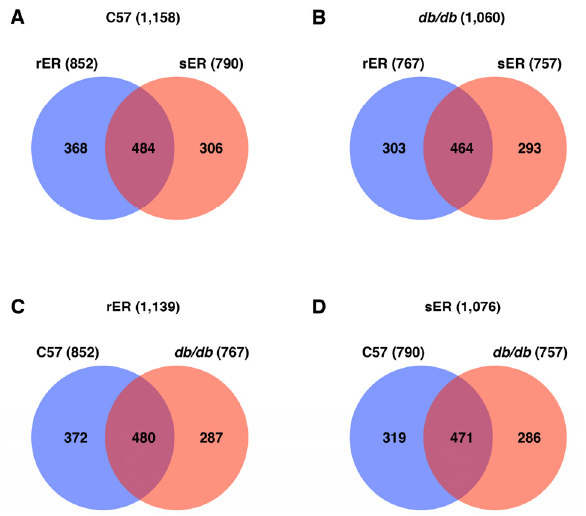
Figure 3. Venn diagrams showing the distribution of the unique ER proteins identified in C57 control and db/db mice livers. ( A ) Control mice livers; ( B ) db/db mice livers; ( C ) rER fraction; ( D ) sER fraction.